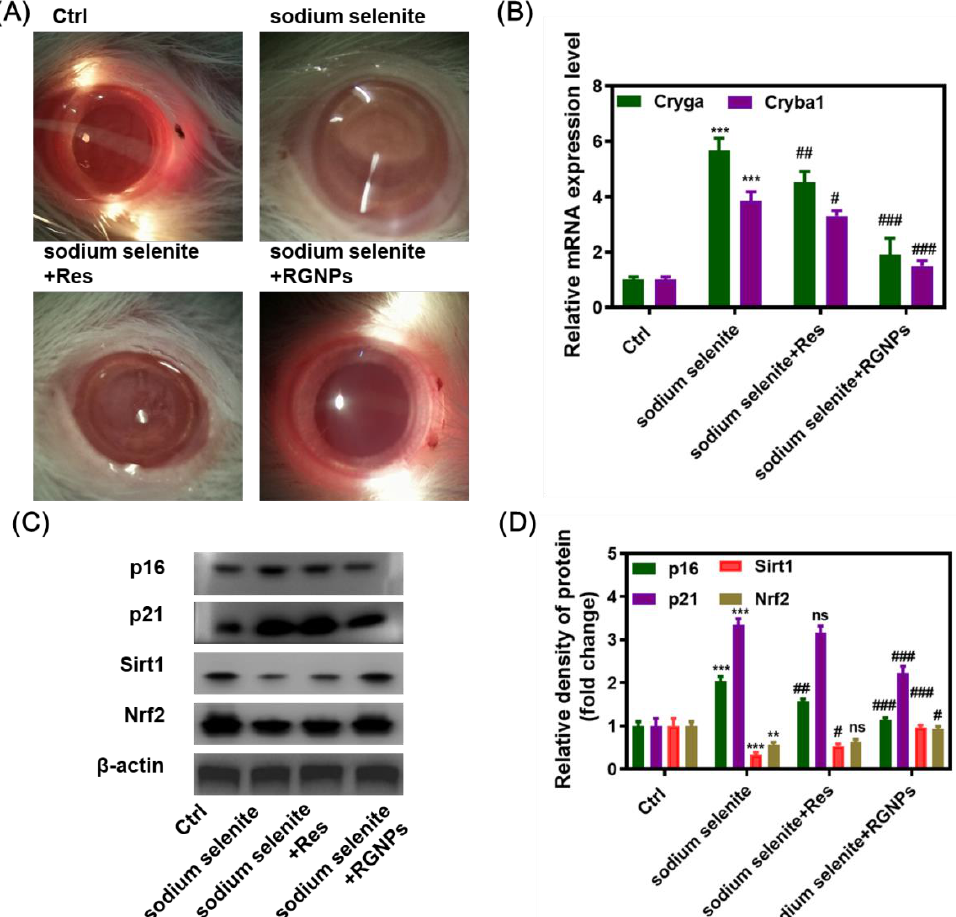
Figure 6. RGNPs delayed cataract development by inhibiting lens senescence in vivo. ( A ) Photographs of lens opacity in rat eyeball after treatment with sodium selenite, sodium selenite +Res and sodium selenite +RGNPs. ( B ) Relative mRNA expression levels of Cryga and Cryba1 in rat lens treated with sodium selenite, sodium selenite +Res and sodium selenite +RGNPs. ( C ) p16, p21, Sirt1 and Nrf2 proteins by sodium selenite, sodium selenite +Res and sodium selenite +RGNP treatment in rat lens were determined by western blotting. ( D ) Relative density of proteins (p16, p21, Sirt1 and Nrf2) by sodium selenite, sodium selenite +Res and sodium selenite +RGNPs treatment in rat lens. ** and *** indicate sodium selenite vs. Ctrl; #, ## and ### indicate sodium selenite +Res or sodium selenite +RGNPs vs. sodium selenite; ns indicated statistically insignificant .